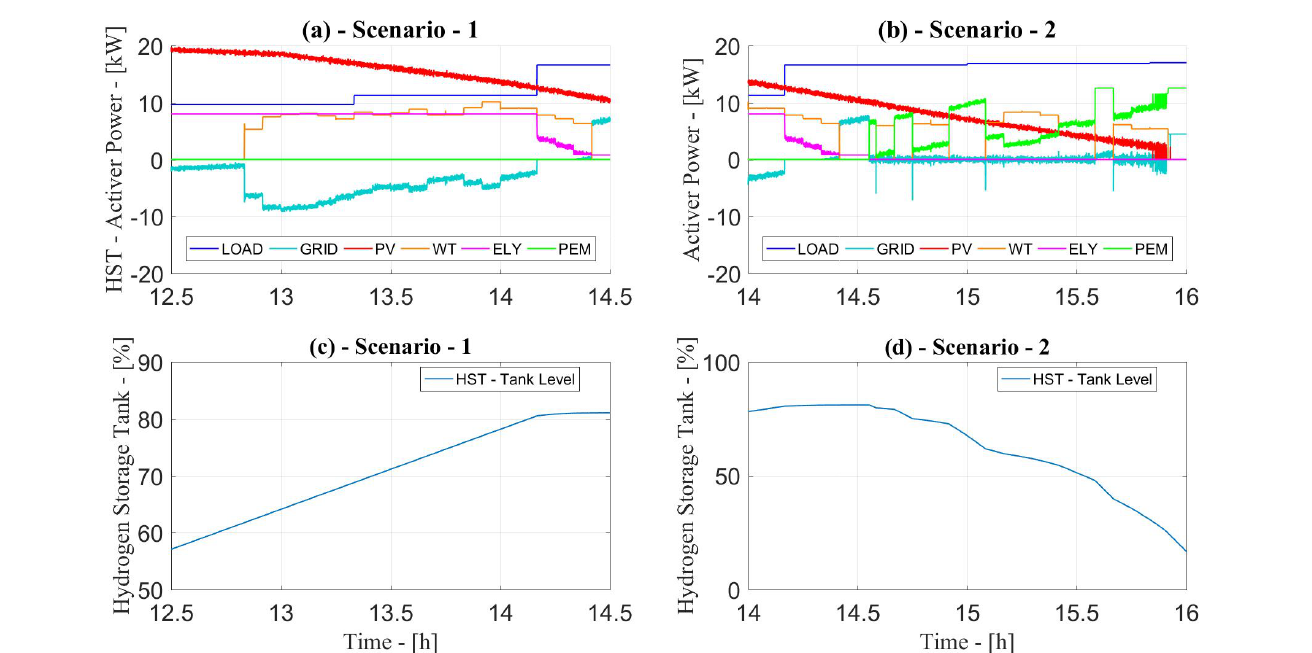
Figure 13. Global model performance of the H µ G in different scenarios using a validation load profile. Scenario 1 : H 2 production; both favorable wind and solar irradiance conditions. Scenario 2 : H 2 consumption; scarce wind speed and solar irradiance